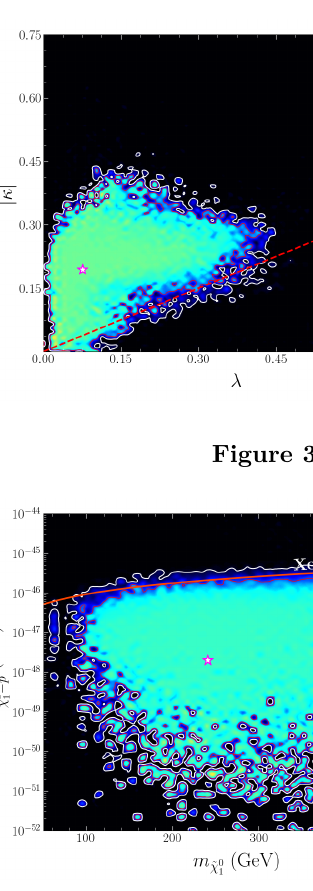
Figure 4 . Same as figure 2, but for h ≡ h 2